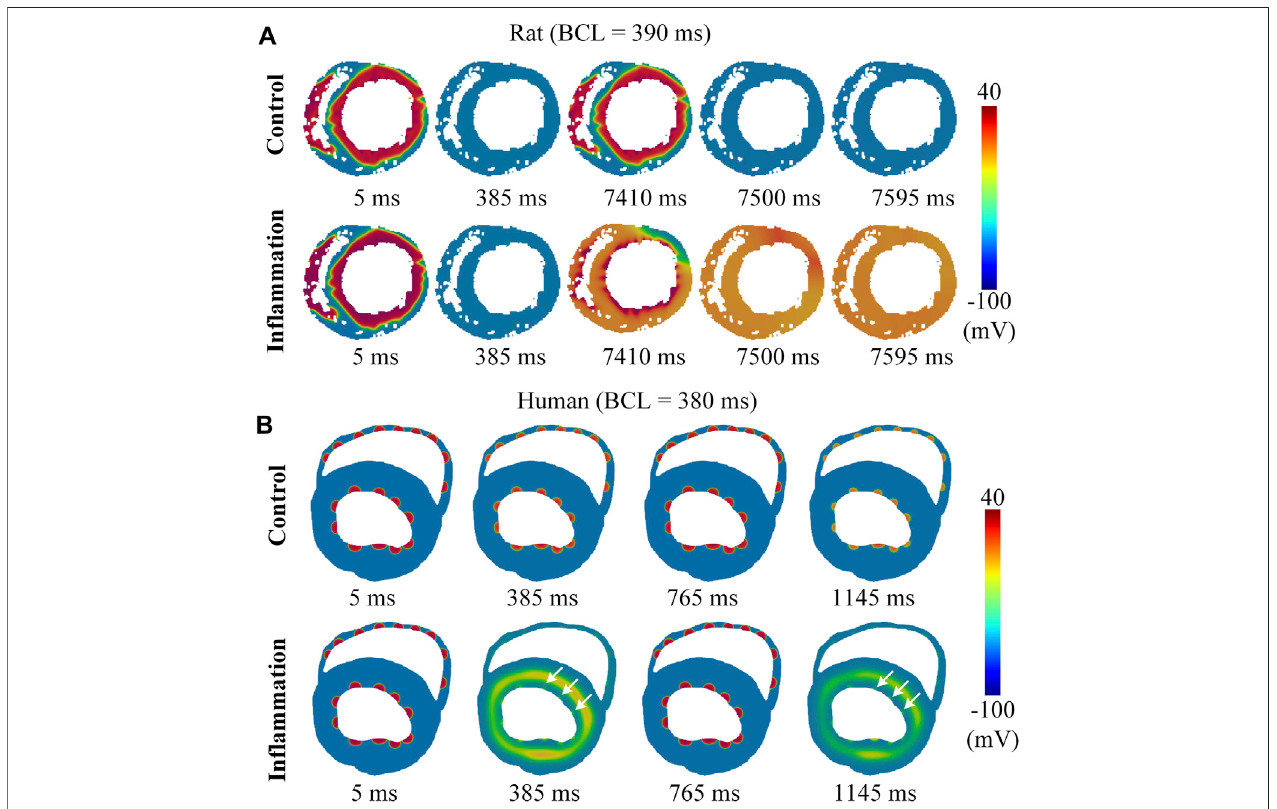
FIGURE7| Theperformanceofthemodelathighfrequency.Conductionwavesunderphysiologicalandin fl ammatoryconditionsathighfrequency (A) forratsand (B) for humans. The white arrow represents stimulus S1, which failed to pace.